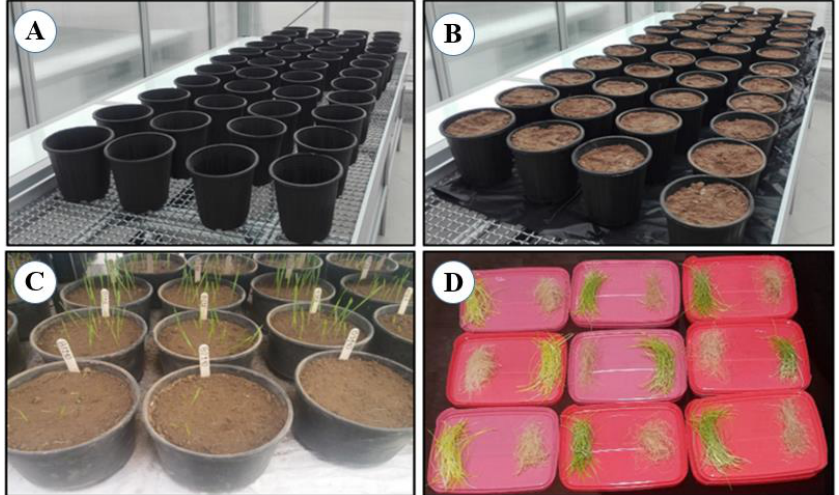
Figure 2. Glasshouse experiment. Inside the glasshouse, each pot was filled with 4 kg of soil, as described in Table 1, and 10 seedlings were planted in eachpot.Watering of the pots took place every other day, and the ambient air temperature was maintained at 24 ± 4 and 10 ± 4 °C (day/night) with a relative humidity of 60% and a day duration of approximately 14 h. ( A ) Randomizing and ( B ) uniformly filling pots with soil, ( C ) preparing pots to measure traits and ( D ) separating samples based on treatments.